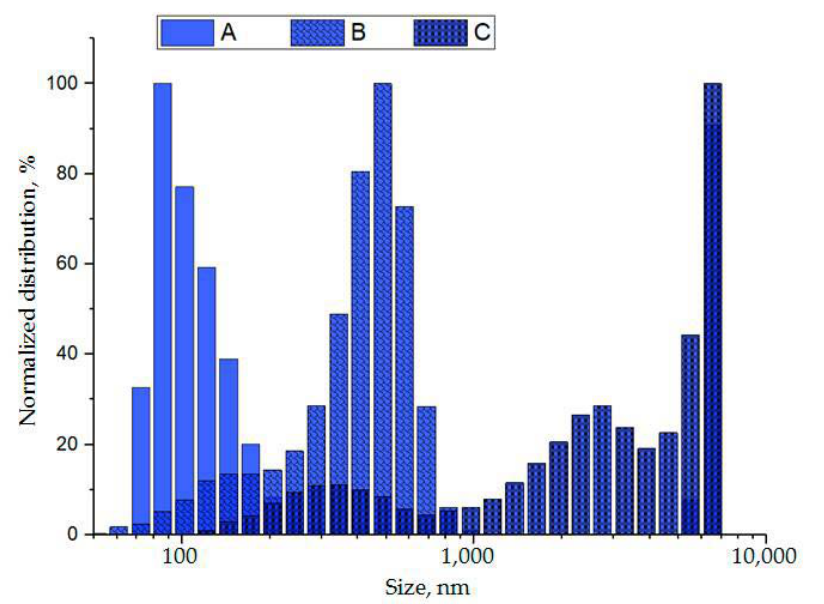
Figure 1. Size distribution of particles in lower phases (LP1) of plasma two-polymer systems (PTPS) formed by polyethylene glycol (PEG) (20 kDa) and dextran (DEX) (450–650 kDa) measured at different concentrations and dynamic viscosity values. A. 3.5% PEG–1.5% DEX, 1.0214 mPa · s; B. 3% PEG–3% DEX, 1.0516 mPa · s; C. 2% PEG–2% DEX, 1.0756 mPa · s.